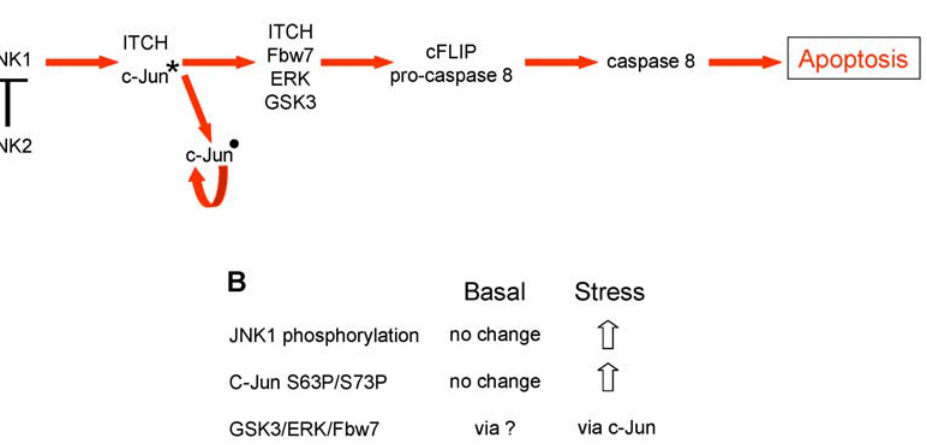
Figure 9. Basal survival of human cancer cells involves JNK2 suppression of a novel pro-apoptotic pathway. (A) JNK2 constitutively represses JNK1-mediated apoptosis. JNK1 is primed to initiate apoptosis which proceeds via the indicated intermediates (see Results). c-Jun dissociates from ITCH upon JNK2 depletion, loses S243P (*) and up-regulates its own transcription ( the MAP kinase pathway operating under basal conditions indicate that the regulation of apoptosis under basal conditions is mechanistically distinct from stress-induced apoptosis.